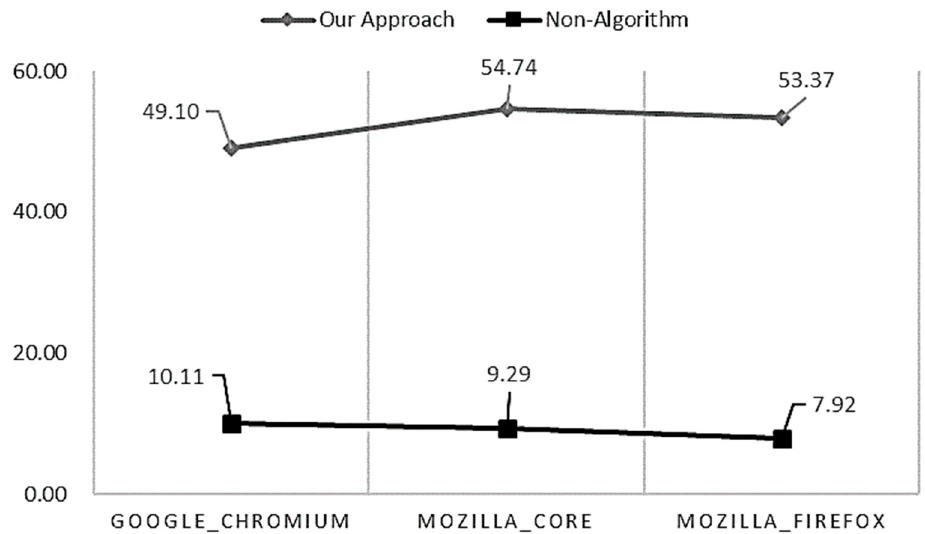
Figure 12. Performance comparison of our approach and non-algorithm.